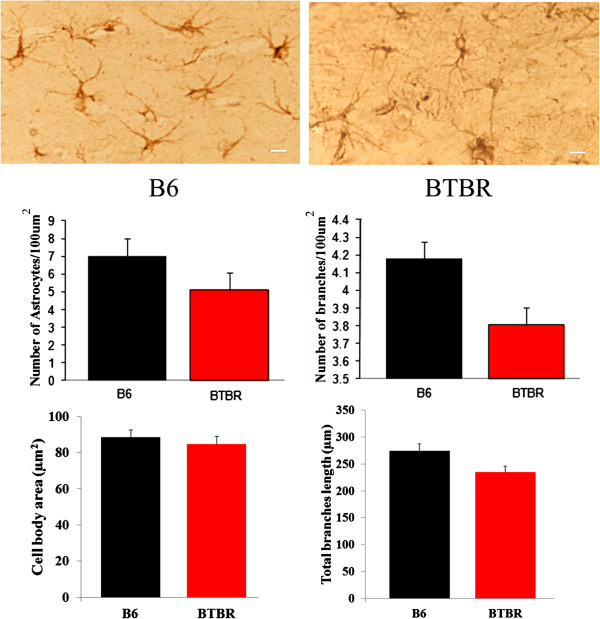
The density and morphology of astrocytes in the brain of BTBR mice. Immunohistochemistry studies were carried out on whole brain sections from six BTBR mice and six age-matched control B6 mice using an anti-glial fibrillary acidic protein (GFAP) antibody (dilution 1:1000). Immunostaining of GFAP (dark brown color) was present in all astrocytes. The density of astrocytes, number of astrocytic branch processes, cell body size and the total branch length were quantified using Image J analysis. Scale bar: 5 μm. Data are shown as mean ± standard error (SE).